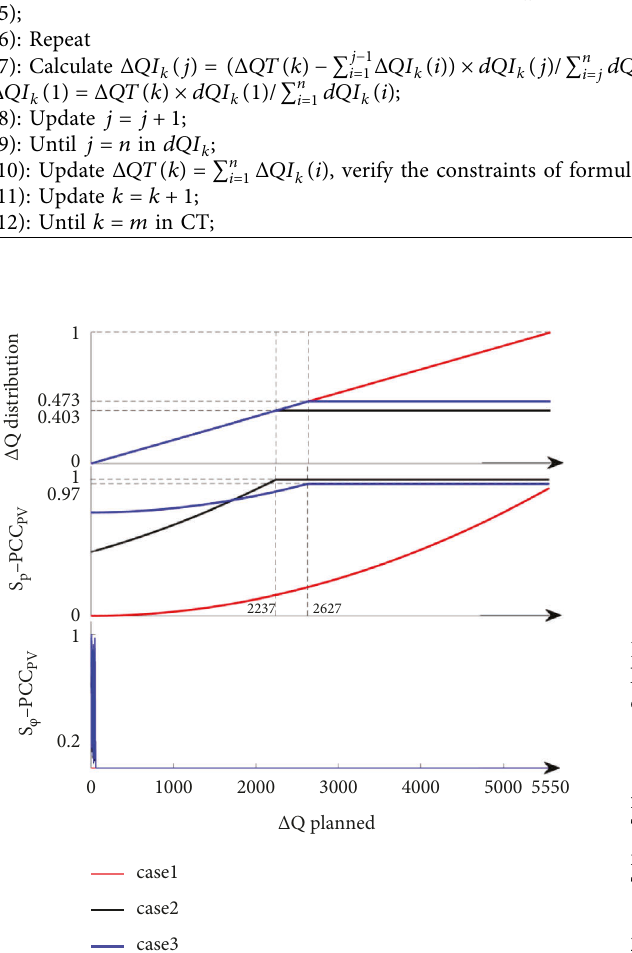
Figure 6: The results of algorithm 2 for the case.